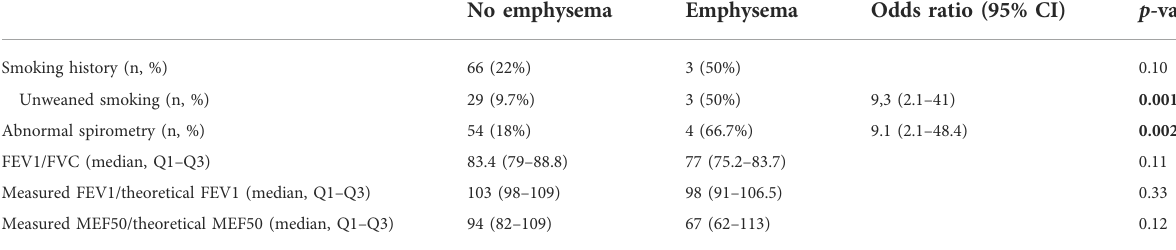
TABLE 4 Characteristics of subjects according to the presence of CT scan